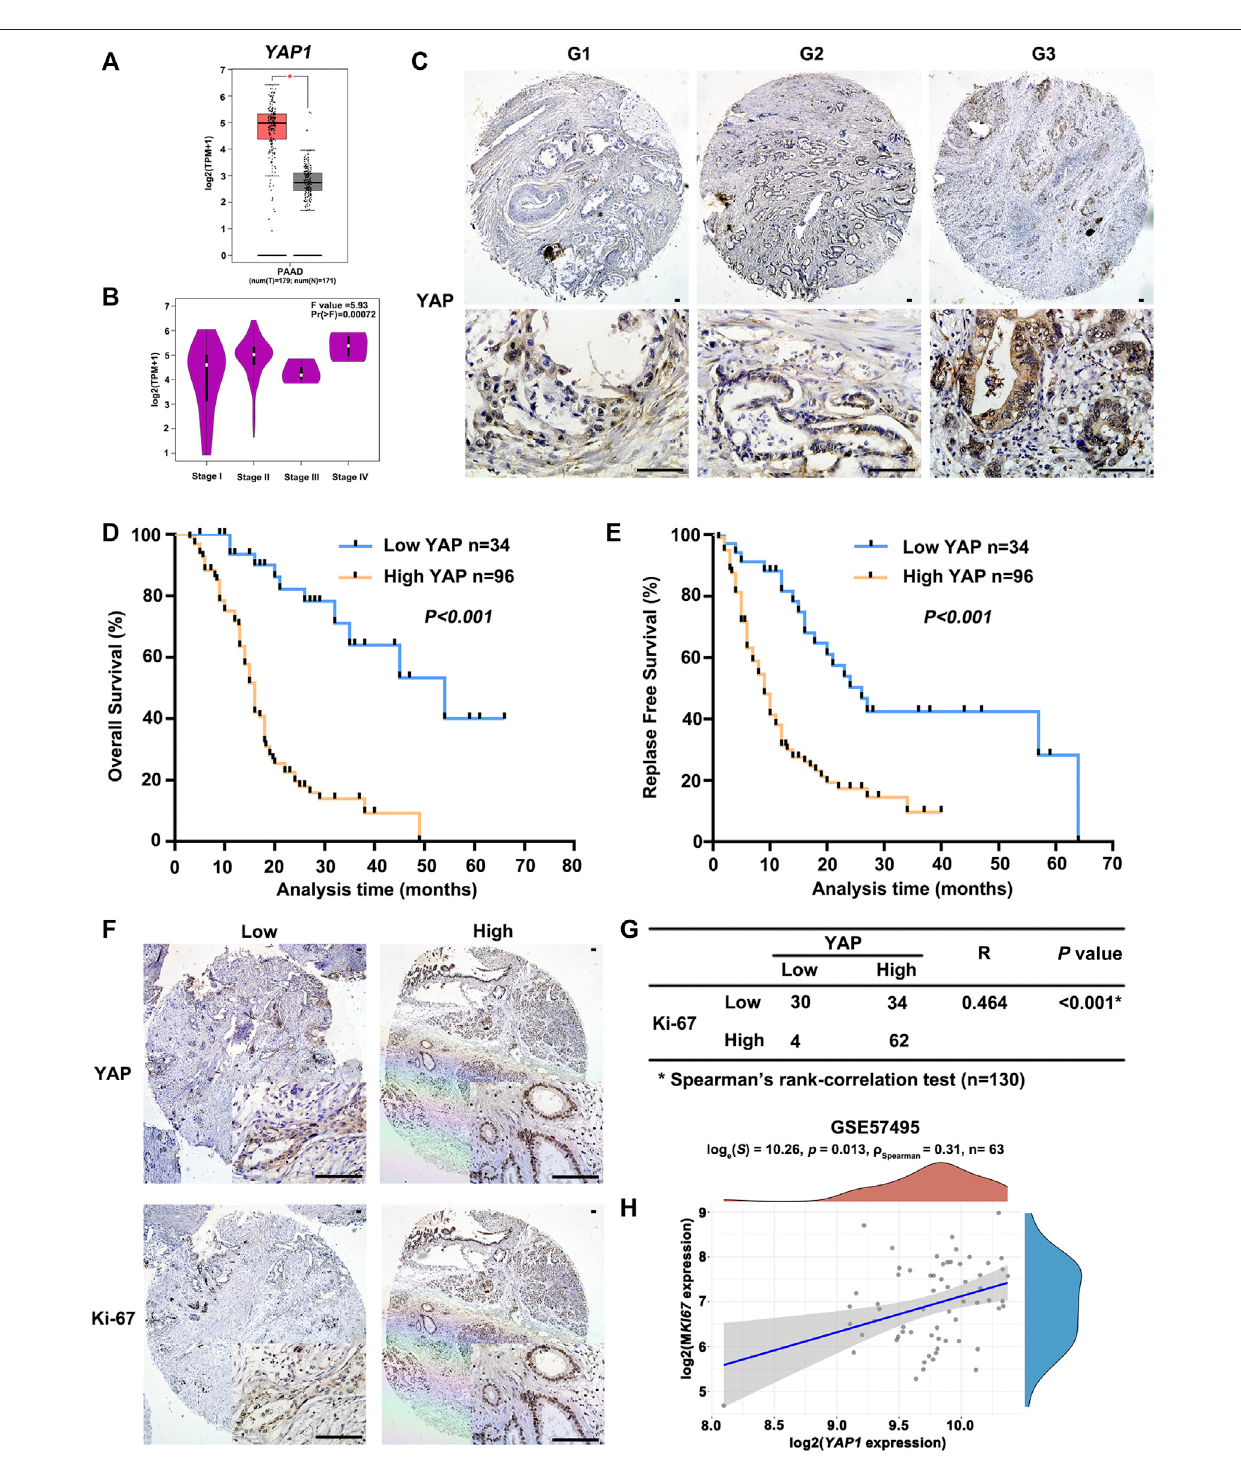
FIGURE3| Thepositivecorrelationbetweentheexpressionof YAP1 andmalignantpotentialofPAAD. (A) Thetranscriptionalpro fi leof YAP1 wasanalyzedinPAAD tissue samples (T) and normal tissue samples (N) obtained from PAAD datasets in TCGA analyzed by GEPIA. (B) Signi fi cant differences in YAP1 expression in different pathologicalstageswereanalyzedbyGEPIA. (C) RepresentativeimagesofYAPimmunostaininginPAADwithdifferenthistologicalgrades.G1,highlydifferentiated;G2, moderately differentiated; G3, poorly differentiated. Scale bar: 100 μ m. (D) Kaplan-Meier curves of overall survival in PAAD patients with YAP expression. AccordingtotheimmunostainingofYAP,thepatients( n =130)weredividedintotwogroupswithloworhighexpression. p valuewascalculatedbythelog-ranktest. (E) Kaplan-Meier curves of relapse-free survival in PAAD patients with YAP expression. p value was calculated by the log-rank test. (F) YAP and Ki67 expression in serial sections of human PAAD tissue microarray by immunostaining. Scale bar: 100 μ m. (G) Correlation analysis of immunostaining results of YAP and Ki67 expression in PAAD tissue microarray. (H) Spearman correlation analysis of YAP1 expression and MKI67 expression, the value represents the correlation p value.